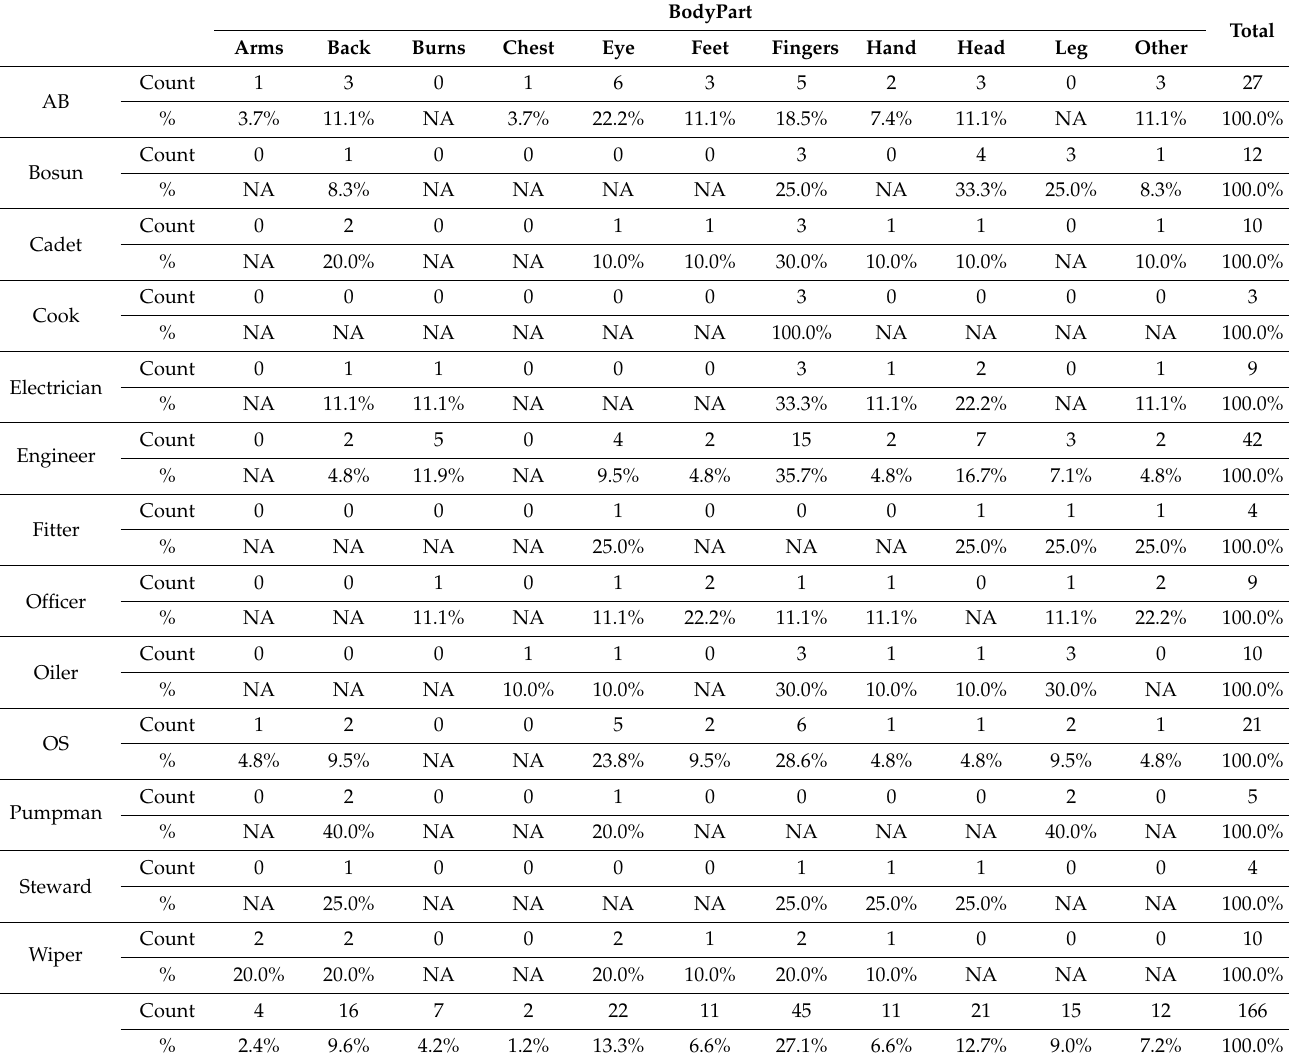
Table 2. Crosstab